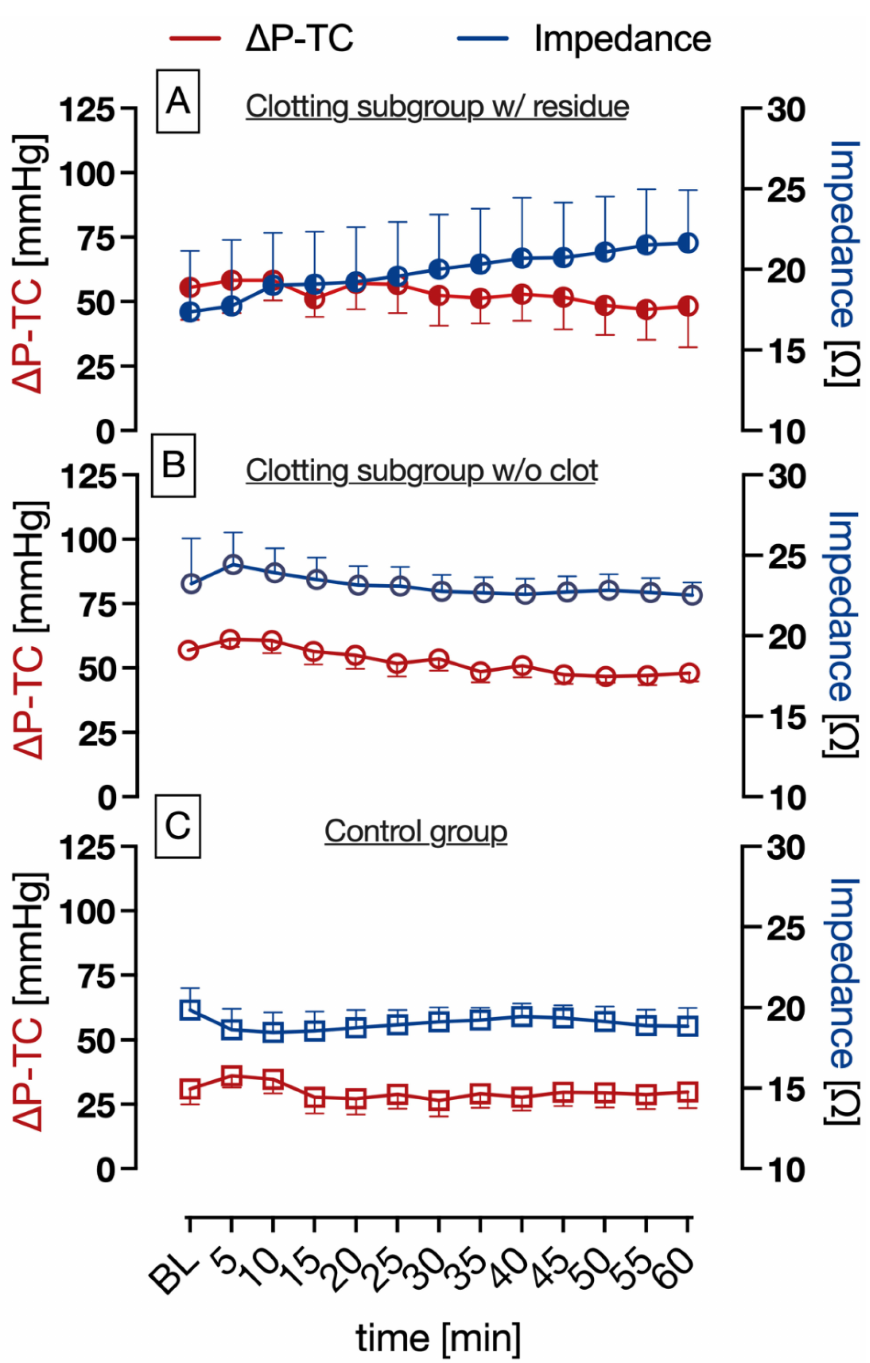
Figure 7. Impedance and pressure difference measurements ( ∆ P-TC) over time. ( A ): clotting subgroup w/residues on impedance-measuring fibers ( n = 2), subtle, non-significant increase in impedance and no significant increase in ∆ P-TC. ( B ): clotting subgroup w/o clot formation ( n = 3), no significant increase in impedance and ∆ P-TC. ( C ): control group ( n = 3), no significant increase in impedance and ∆ P-TC; ANOVA; mean ±